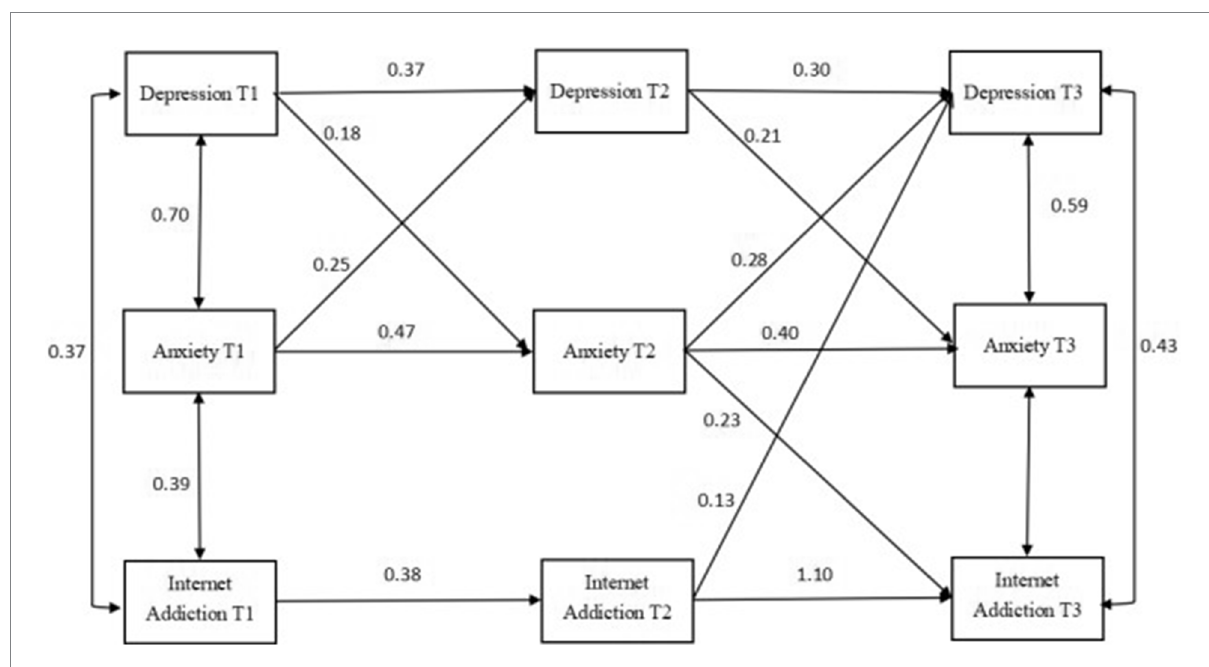
FIGURE 2 Cross-lagged analysis of depression, anxiety, and Internet addiction. T1 is the baseline data and T2 and T3 are follow-up data. The solid line indicates statistical significance.